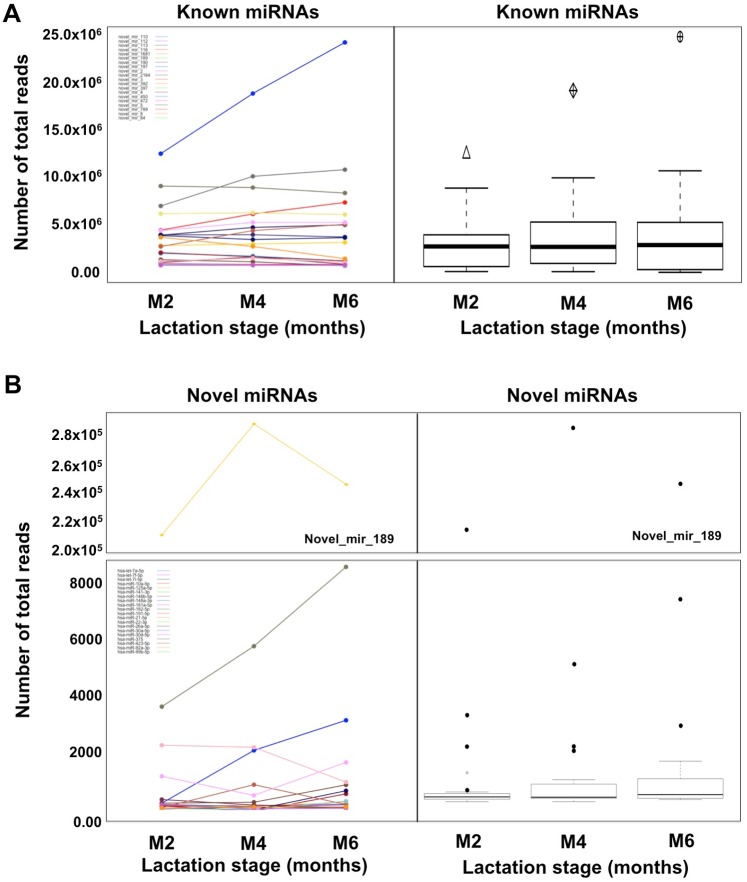
Comparison of expression of the top 20 most highly and commonly expressed known (A) and the 20 most highly expressed novel (B) miRNAs in the cell and lipid fractions of HM considered together, during the three stages of lactation examined (months 2, 4 and 6).Due to the variability in the total reads between novel miRNAs (B), novel_mir_189 is presented separately from the rest. From the top 20 known and novel miRNA species, only the most highly expressed known miRNA let-7f-5p was expressed at higher levels from month 2 to month 6 (p<0.01).